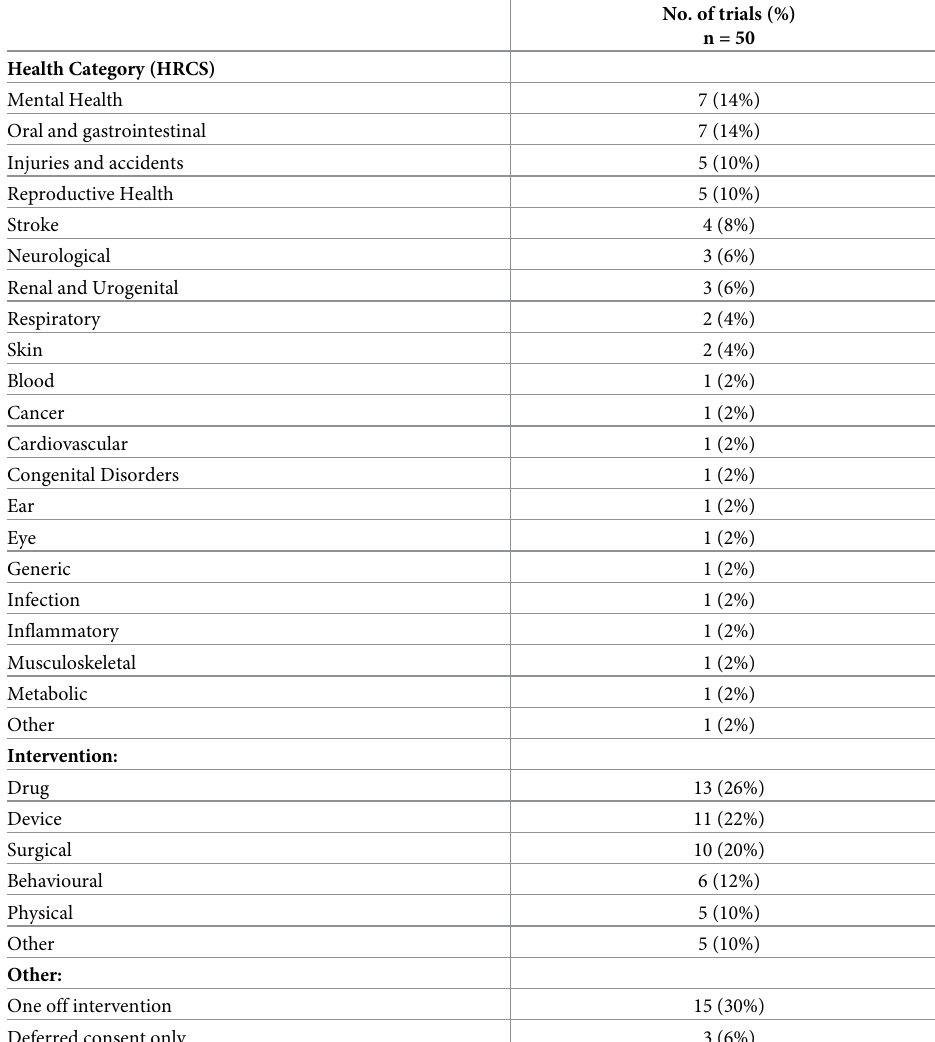
Table 2. Characteristics of included